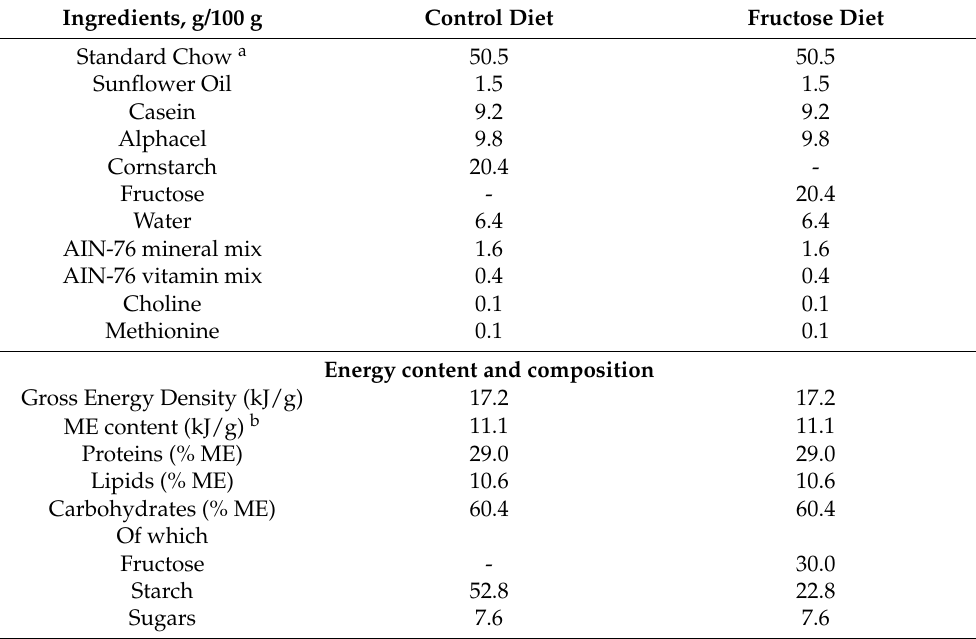
Table 1. Ingredients and nutritional composition of experimental